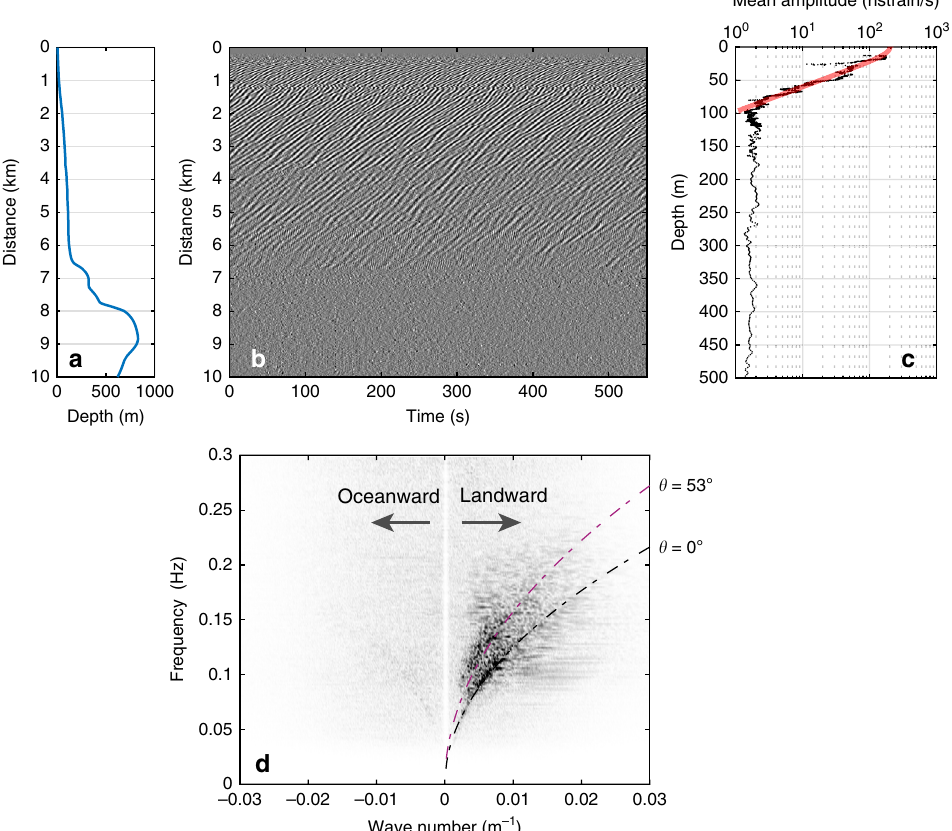
Fig. 2 Seismic sea fl oor signal caused by oceanic surface gravity waves. a Depth pro fi le and b 550s long record of strain-rate along the fi rst 10 km of the cable. Each trace is normalized by its maximum amplitude. The data show periodic oscillations mainly propagating towards the shore. c Mean strain-rate over the same distance as a function of depth and theoretical prediction for intermediate depth regime and a wavelength of 100 m. d Frequency- wavenumber f – k decomposition of the strain-rate signal, for seaward ( k < 0) and landward ( k > 0) components, and linear gravity wave dispersion curves for two different incidence angles assuming a water depth of 100 m (dashed